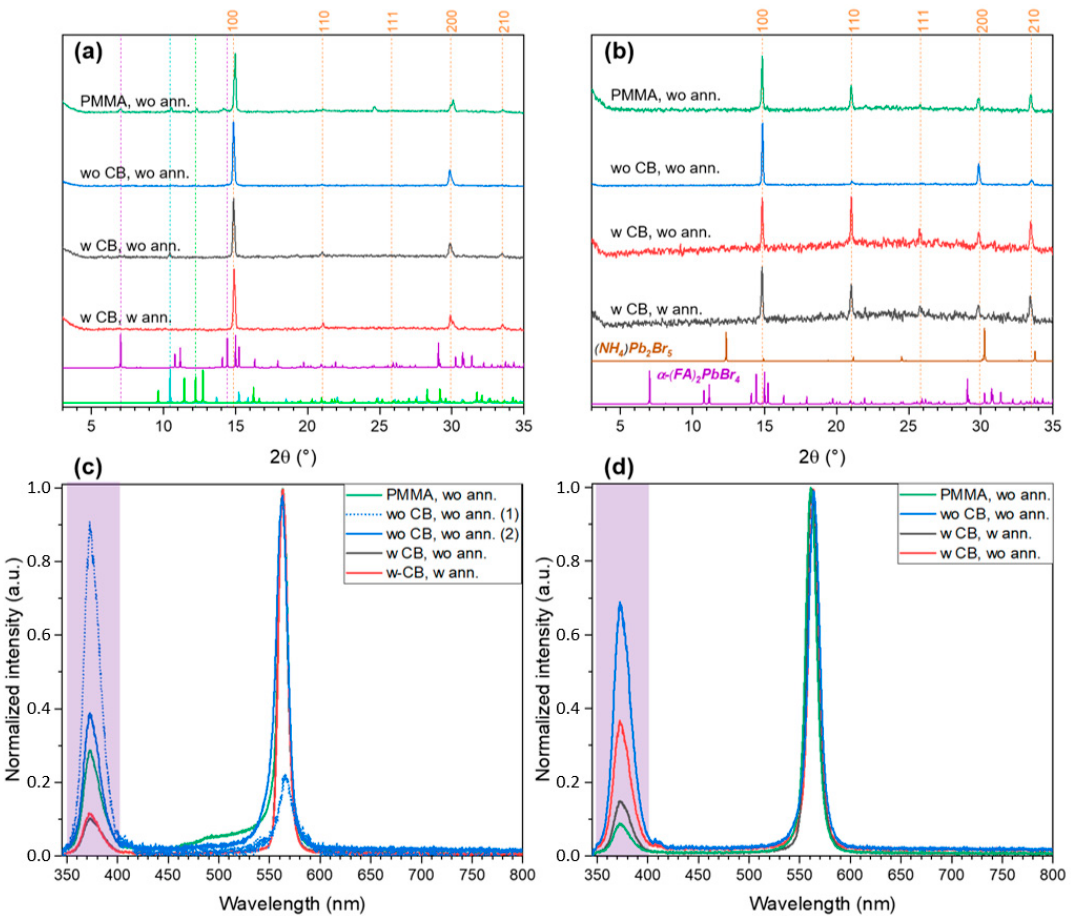
Figure 6. The XRD patterns ( a , b ) and PL spectra ( c , d ) of thin films with FABr:PbBr 2 = 1.5 spin-coated at different conditions from DMSO ( a , c ) and DMF ( b , d ) solutions. The dashed orange lines denote the reflections of FAPbBr 3 perovskite, other dashed lines indicate the positions of the most relevant reflections corresponding to reference XRD pattens plotted below (FA 2 PbBr 4 by vivid violet, FAPbBr 3 ·DMSO by lime green, FA 2 PbBr 4 ·DMSO by turquoise). The light violet strip corresponds to the main band in the spectra of UV lamp (excitation source). For the FABr:PbBr 2 ratio of 2:1, crystallization from DMSO also begins with solvates